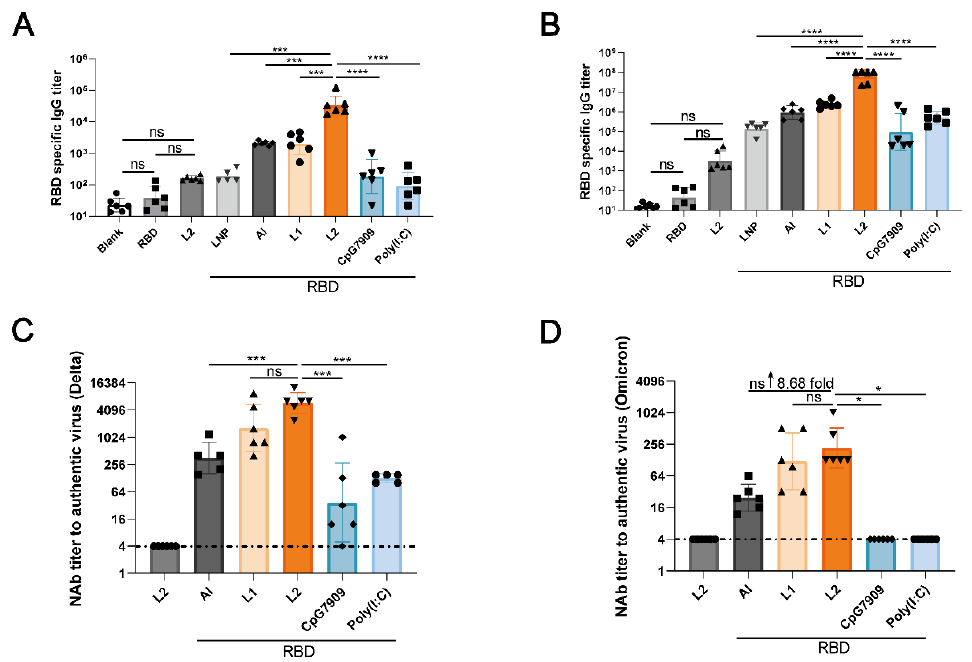
Figure 5. L2 improved the immunogenicity of the RBD compared with CpG 7909 and poly(I:C). ( A , B ) RBD-specific IgG titers in Blank, RBD, L2, RBD + LNP, RBD + Al, RBD + L1, RBD + L2, RBD + CpG7909, and RBD + Poly(I:C) groups at 14 days after the 1st immunization and at 14 days after the 2nd immunization. ( A ) At 14 days after the 1st immunization. ( B ) At 14 days after the 2nd immunization. ( C , D ) NAb titers against authentic Delta and Omicron variants in L2, RBD + Al, RBD + L1, RBD + L2, RBD + CpG7909, and RBD + Poly (I:C) groups at 14 days after the 2nd immunization. ( C ) Delta variant. ( D ) Omicron variant. * p < 0.05. *** p < 0.001. **** p < 0.0001. n = 6 for each group. RBD is the recombinant protein donated by Anhui Zhifei Longcom Biopharmaceutical Co., Ltd. Hefei, China.